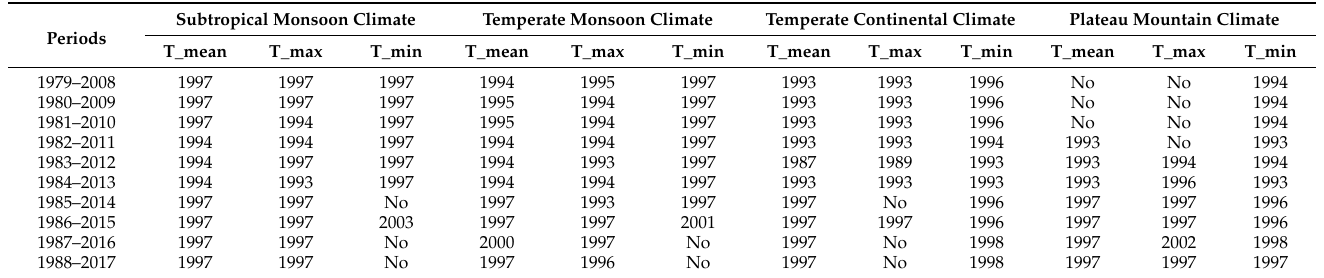
Table 5. Temperature mutation time at different periods for the four different climate zones within Gansu Province at each